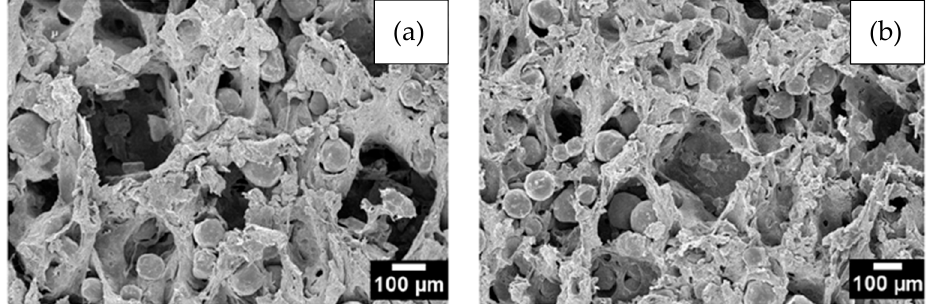
Figure 5. Secondary electron SEM images of a Ti sample debonded in water for 23 h showing in (a) and (b) the cubic voids formed due to the removal of the cubic-shaped space holder and the binder structure. Adapted and reproduced with permission [72]. Copyright 2015, Elsevier.